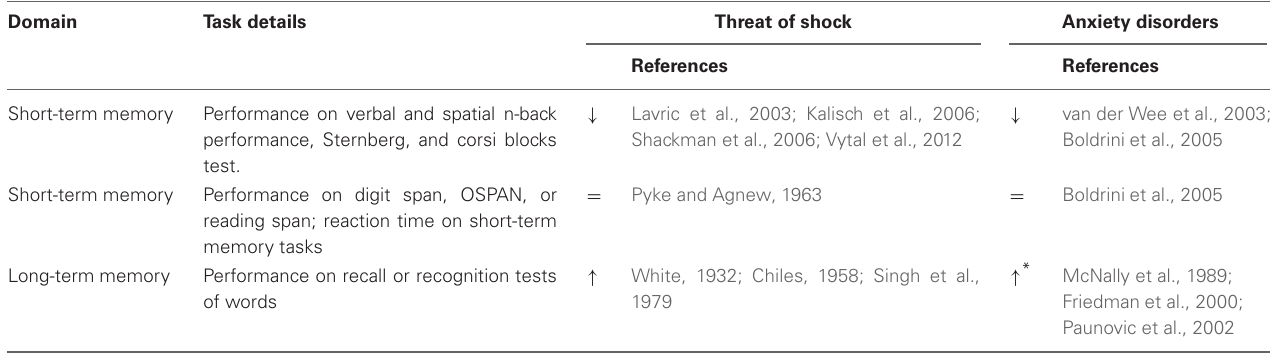
Table 4 | Effects of anxiety on memory (arrows represent direction of